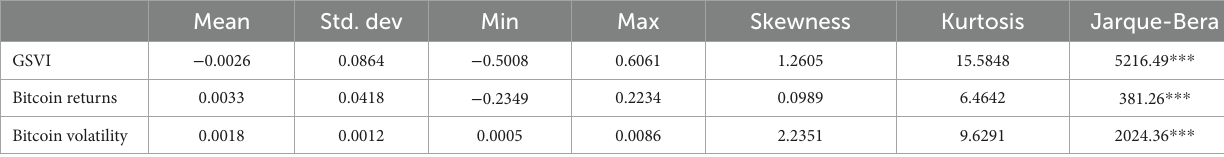
TABLE 1 The descriptive statistics of GSVI on the pandemic and the returns and volatility of Bitcoin